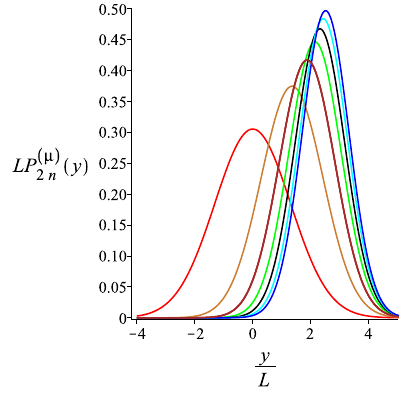
+ π i , 2 6 = 12.5, , φ µ = 0, l p L 4